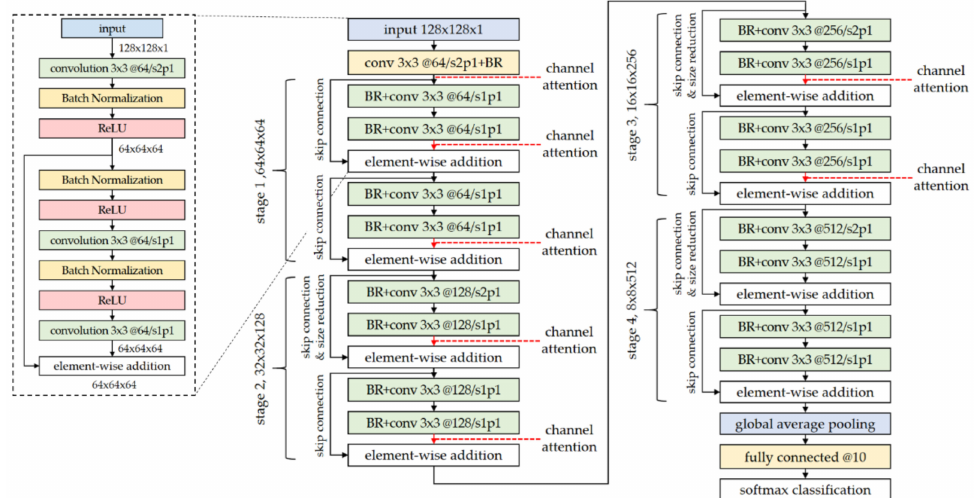
Figure 1. Structure of the ResNet18 modified for SAR-ATR application. The above ResNet18 has 18 layers with learnable parameters and 8 skip connections, identical to the original ResNet18. The main modifications are: the input size, the receptive field size of the first convolutional layer, the number of nodes of the last fully connected layer, and the adoption of the pre-activation